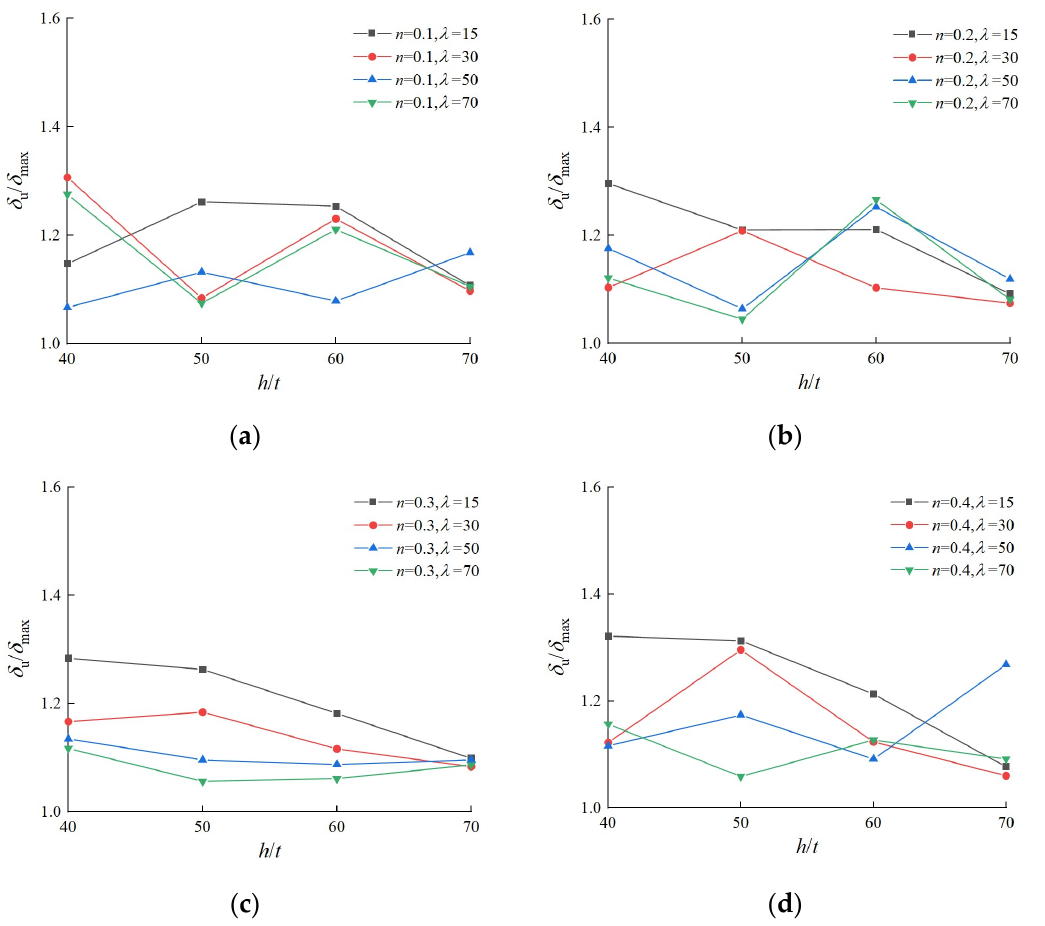
Figure 22. The effect of h / t on δ u / δ m . ( a ) n = 0.1; ( b ) n = 0.2; ( c ) n = 0.3; ( d ) n = 0.4.